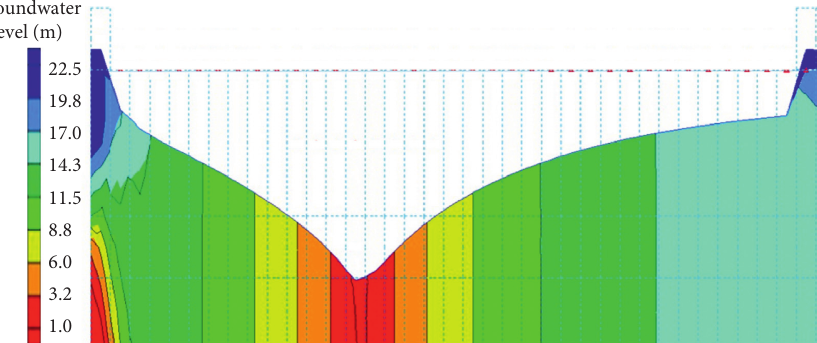
Figure 8: The profile of the groundwater table after the fourth dewatering stage.